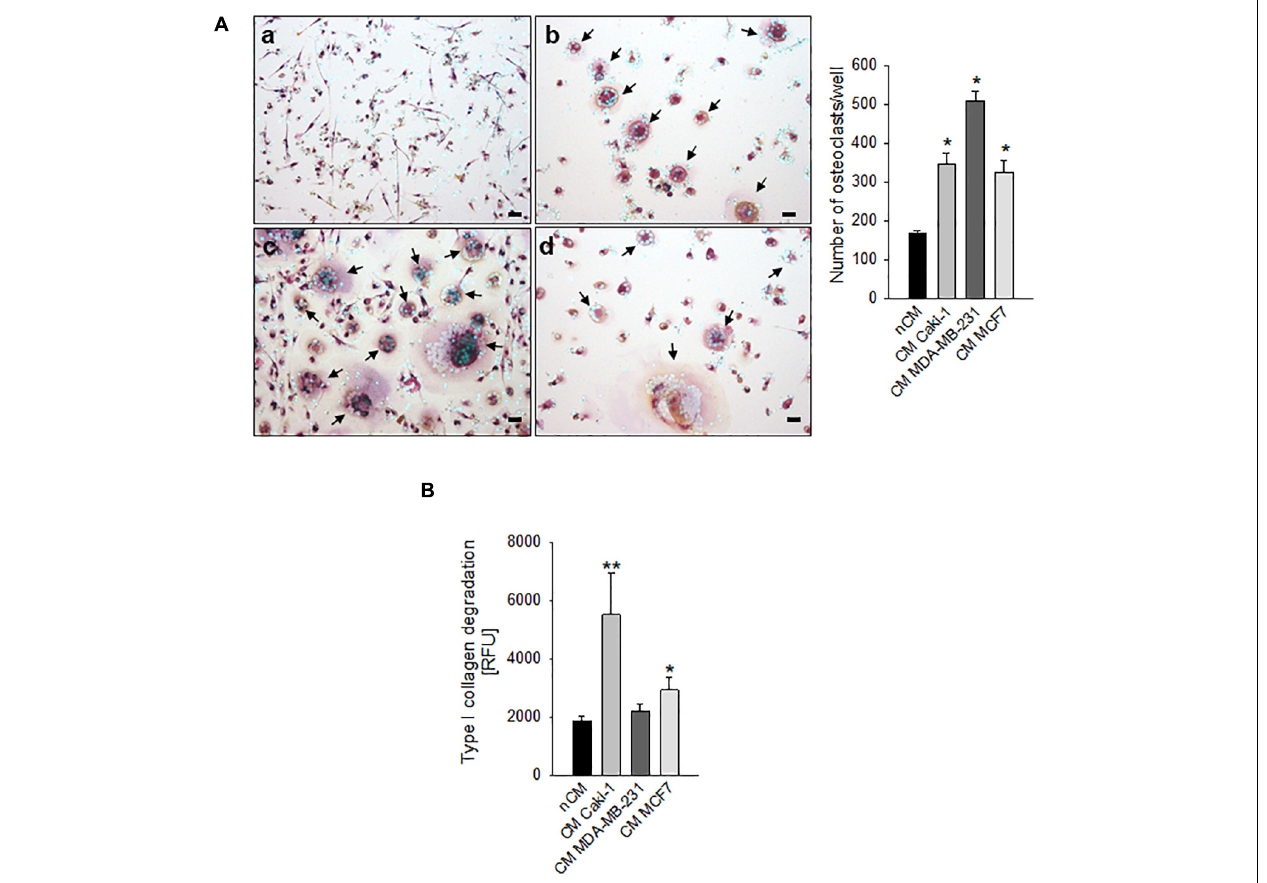
FIGURE 1 | Carcinoma cells directly induced human osteoclast (hOC) differentiation and activity. (A) Graphs and representative images of the number of multinucleated TRACP + hOC after the incubation with non-conditioned medium (nCM) (a) and with the conditioned medium (CM) of Caki-1 (b), MDA-MB-231 (c), and MCF7 (d) carcinoma cell lines. Mean ± SEM ( n = 4, * p < 0.05 vs. nCM), scale bar 25 µ m. Nuclei were counterstained with Hoechst 33258, black arrows indicate multinucleated TRACP + hOC. (B) Type I collagen degradation activity of differentiated OC exposed to the conditioned medium (CM) of Caki-1, MDA-MB-231, and MCF7 carcinoma cell lines. Non-conditioned medium (nCM) was used as a negative control. Mean ± SEM ( n = 8, * p < 0.05 and ** p < 0.01 vs.